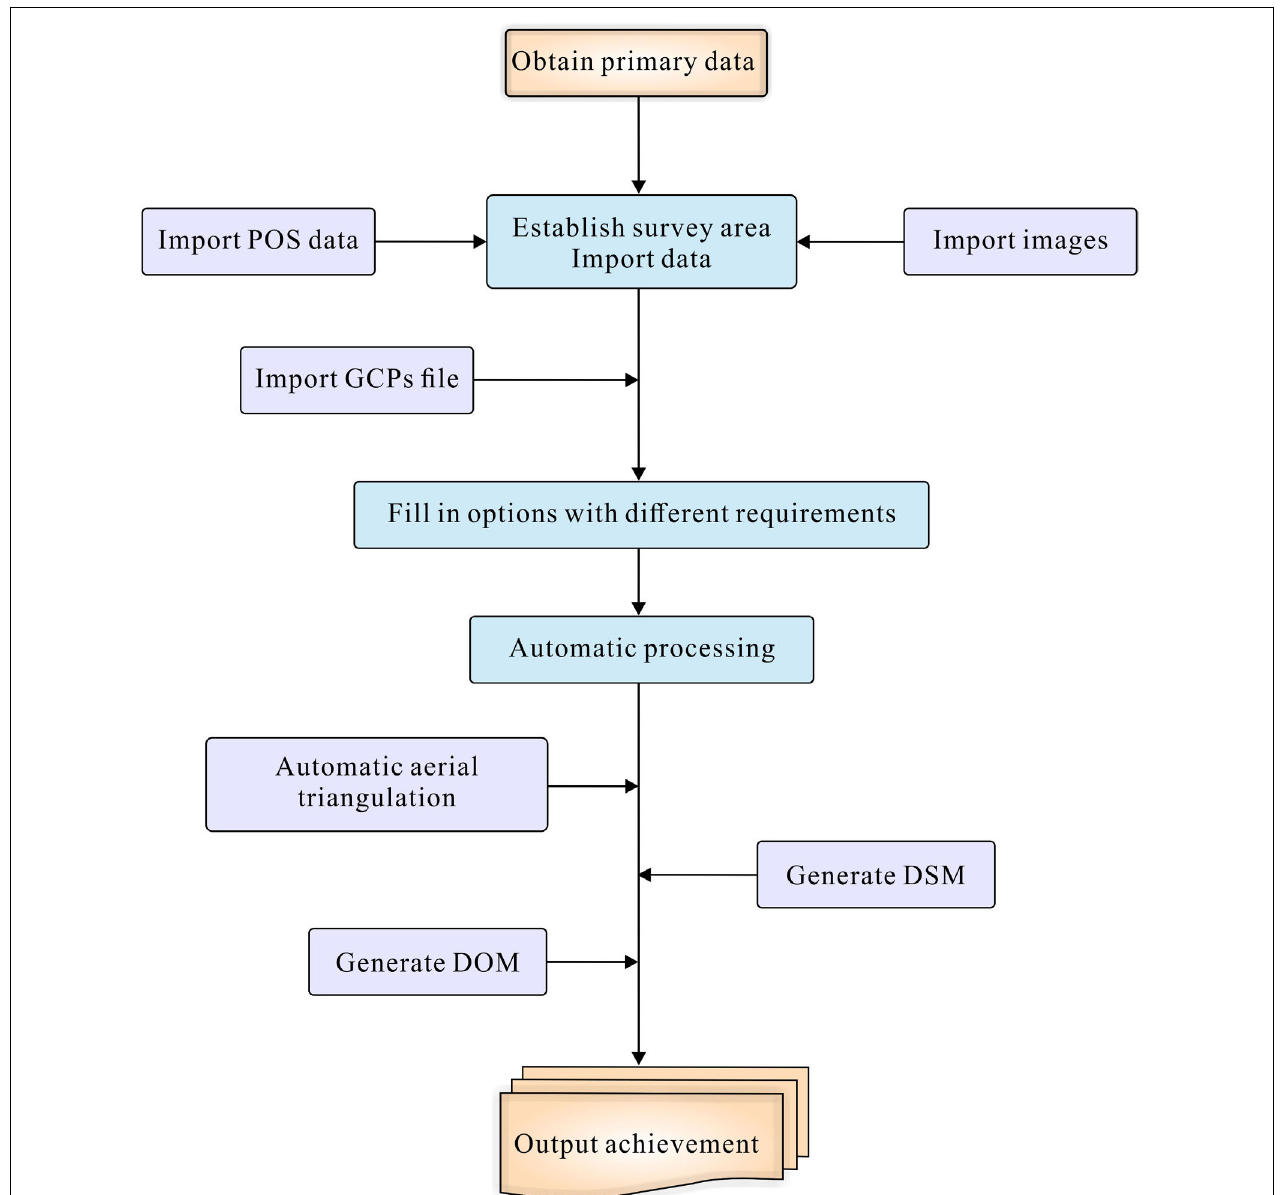
FIGURE 5 | Flowchart of UAV data